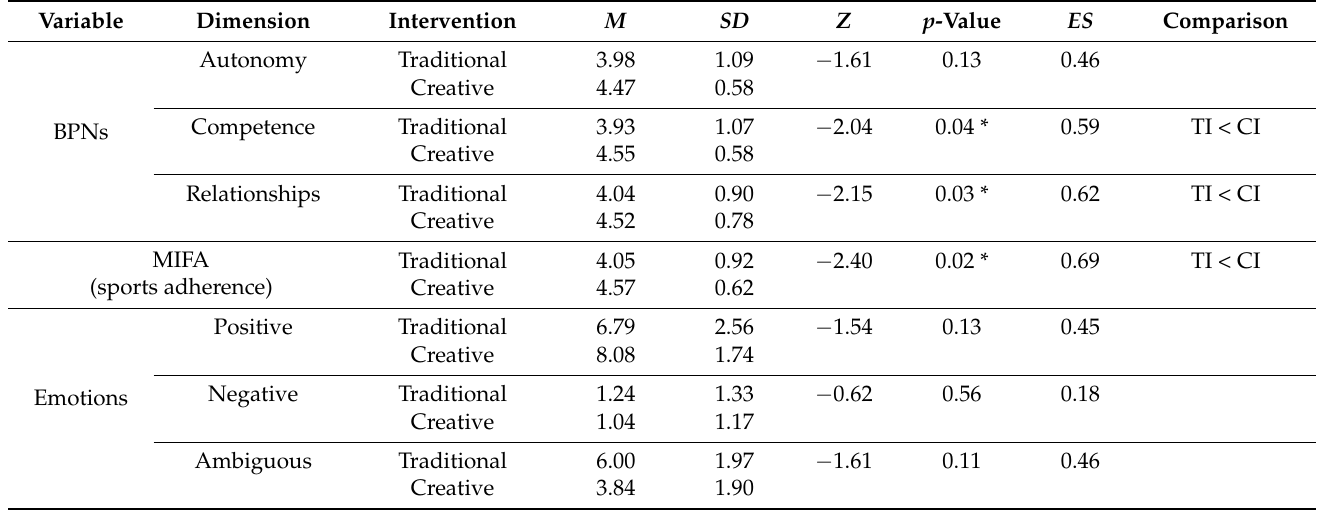
Table 2. Differences in psychological variables were analyzed according to the intervention type.